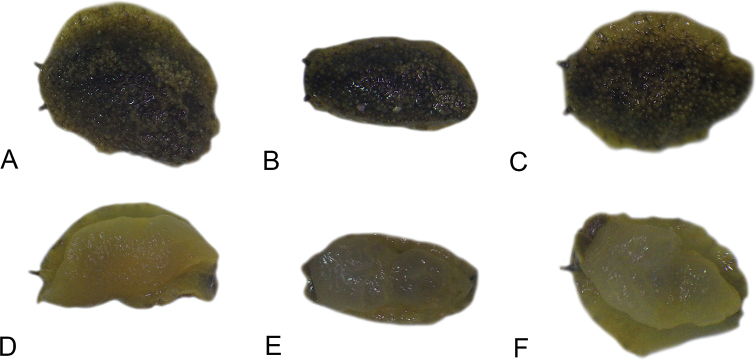
Live animals, Peronia
setoensis, Japan, Honshu A holotype, dorsal view, 20 mm long [5383] (NSMT-Mo 78985) B dorsal view, 10 mm long [5384] (NSMT-Mo 78986) C dorsal view, 12 mm long [5385] (NSMT-Mo 78986) D ventral view, same as A; E ventral view, same as B; F ventral view, same as C.